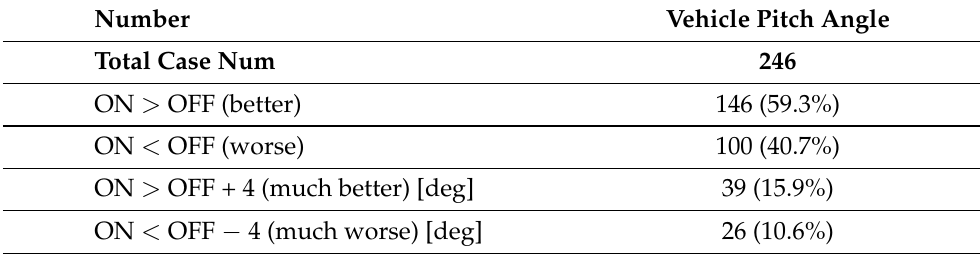
Figure 12. Comparison of the effect when DBD-PA is switched ON and OFF on the maximum vehicle pitch angle. Table 5. Evaluation of DBD-PA